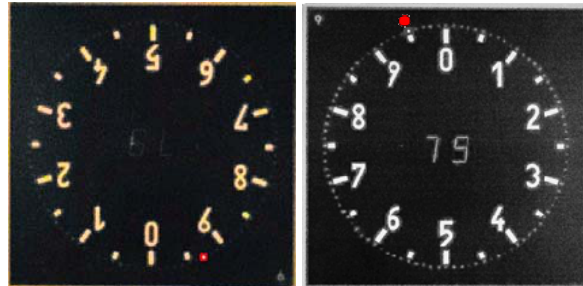
Figure 8. Investigation of simultaneous shutter